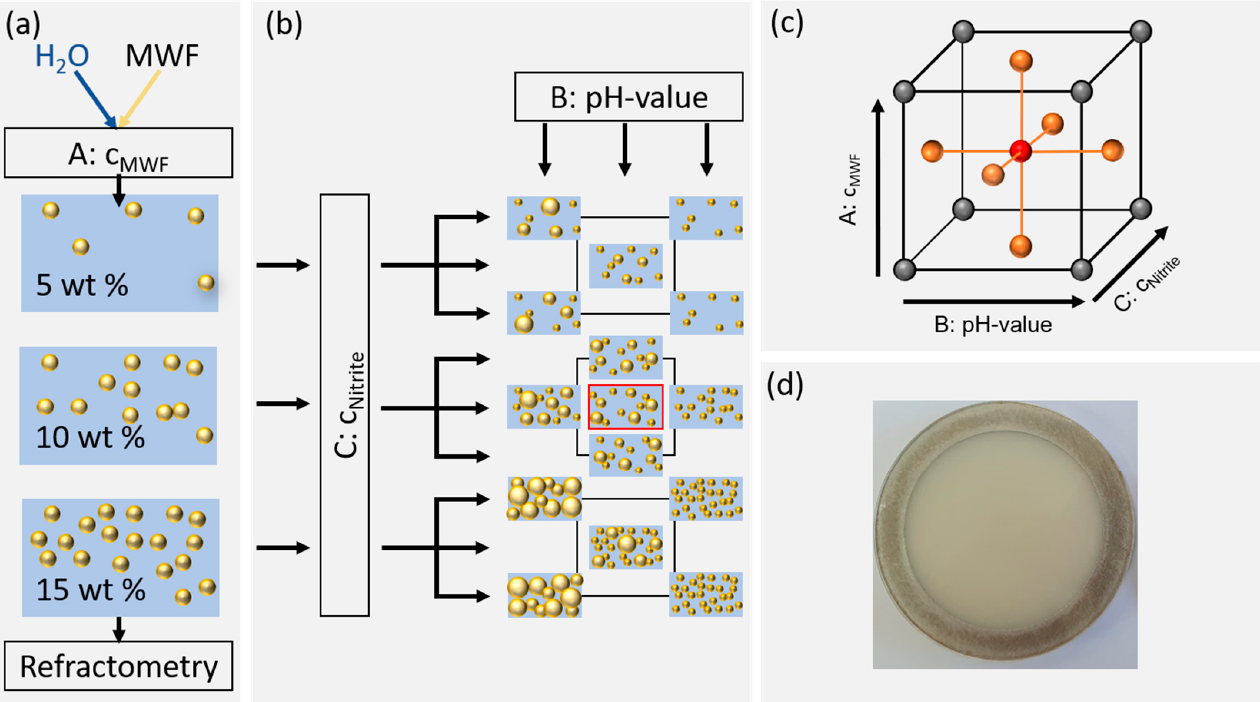
Figure 1. Illustration of sample preparation and the factor level settings according to the response surface methodology. ( a ) Preparation of the desired MWF concentrations and control by refractometry. ( b ) Factor level settings of pH and nitrite concentrations. ( c ) Schematic representation of the examined experimental space. ( d ) Photograph of a typical sample in a quartz cuvette (10 wt% MWF concentration).